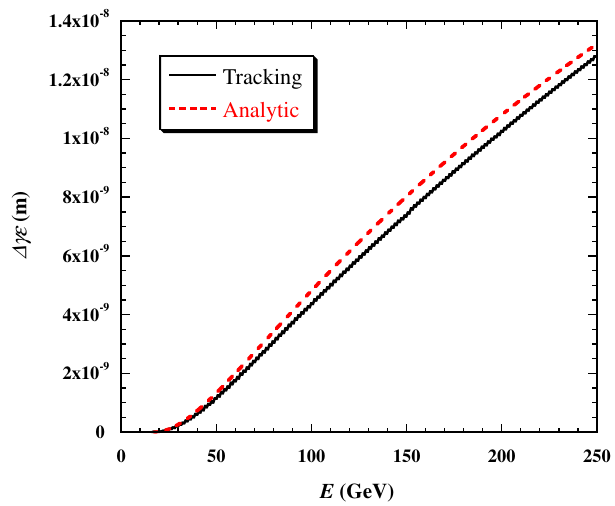
FIG. 2. Emittance growth induced by cavity tilt 15 (cid:10) rad (RMS), as a function of beam energy. Results of tracking simulation (solid line) and the analytic formula (dashed line) for the ILC main linac.